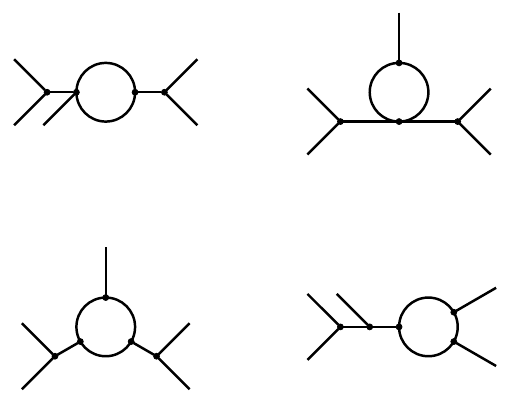
Figure 4 . The one-loop topologies leading to non-genuine finite or divergent diagrams, the internal loop with three legs can be compressed into a three-point